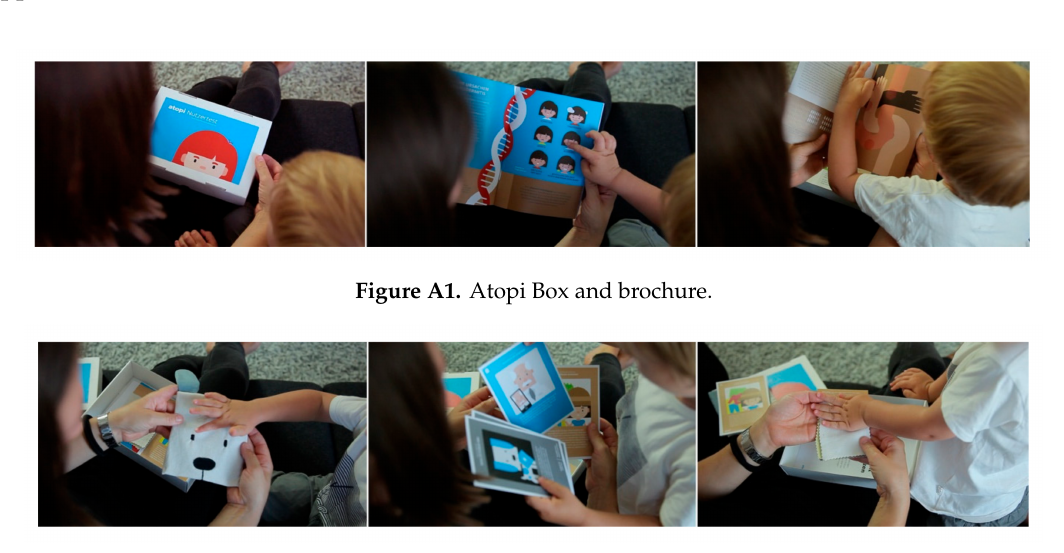
Figure A2. Cool pad “Coolie”, cards, and fabric swatches.